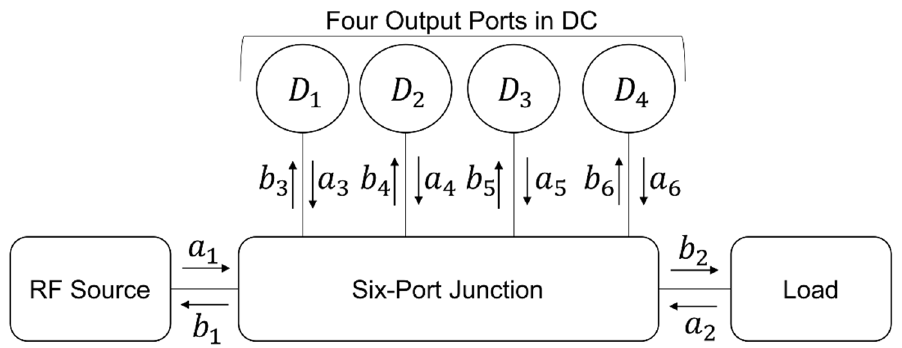
Figure 2. Block scheme of the sensing board.